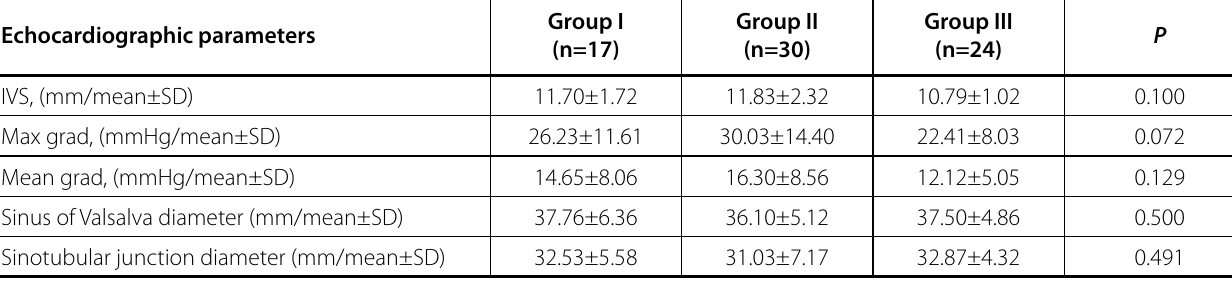
Table 4 . Postoperative echocardiographic parameters.